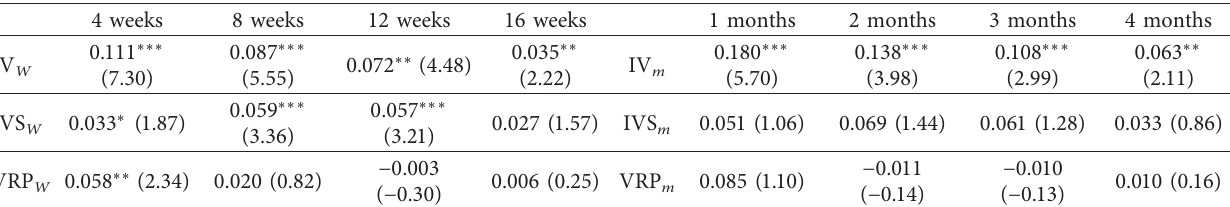
Table 7: Forecasting power of weekly and monthly IV, IVS, and VRP on market